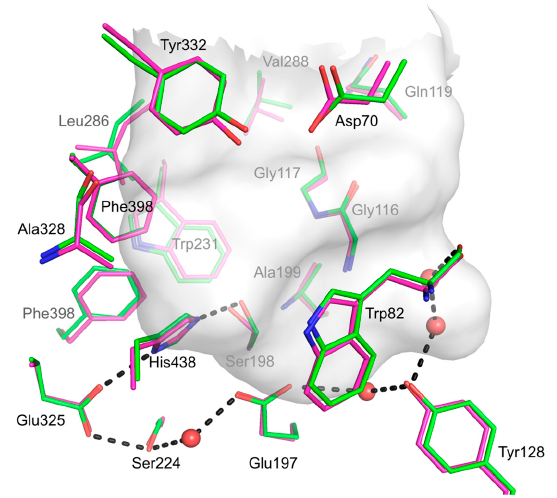
Figure 7. Active site gorge comparison of hBChE-7 and recombinant hBChE produced in CHO cells. Residues forming the active site triad (Ser198, Glu335, and His438) and those forming the active-site gorge are represented as sticks. Carbon atoms are represented in green and magenta for hBChE-7 structure (PDB ID 6EMI) and hBChE expressed in CHO cells (PDB ID 1P0I), respectively. Nitrogen atoms are represented in blue and oxygen atoms in red. Water molecules are represented as red spheres. The active site gorge is represented as a semi-transparent grey surface.